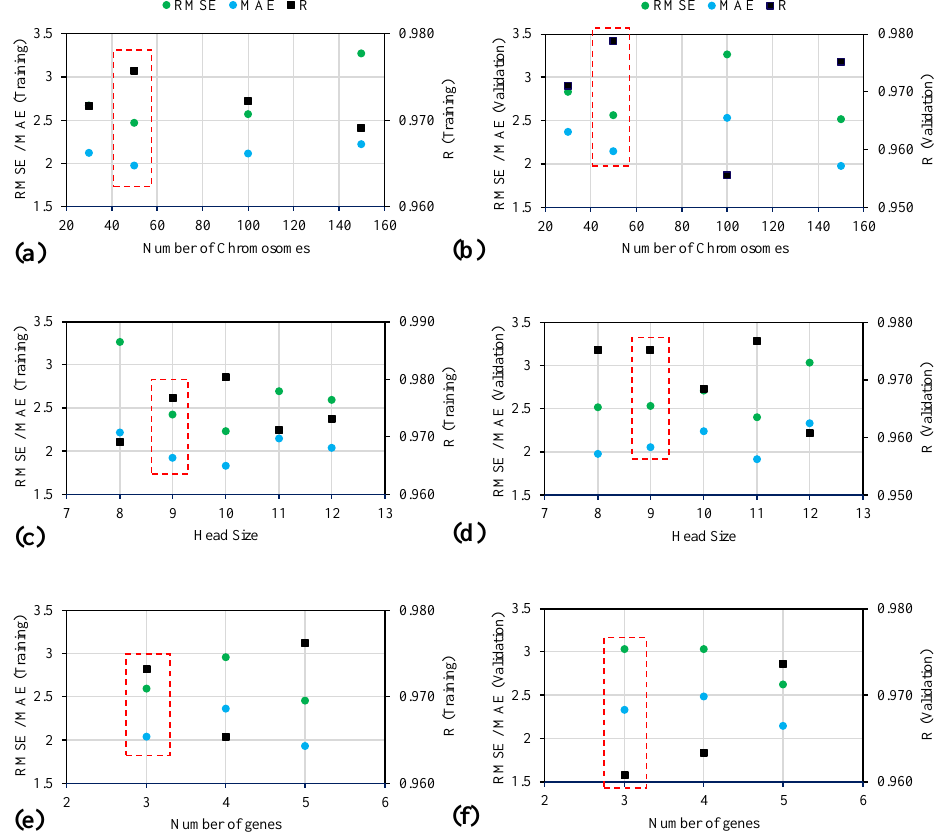
Figure 2. Evaluating the effect of genetic parameters on the performance of models (MAE, R, RMSE) for the case of ( a , b ) number of chromosomes, ( c , d ) head size, and ( e , f ) number of genes. Table 3. Pearson correlation matrix for the inputs and output prameters CS 28d of waste PET/SCM blended cementitious grout